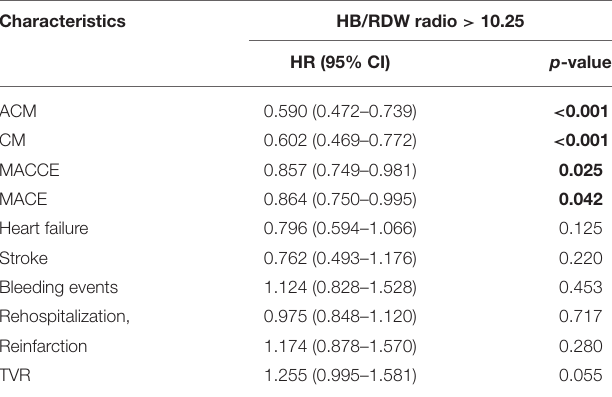
TABLE 3 | Univariate logistic regression analysis of ACM, cardiac death, MACCEs, and MACEs. Characteristics